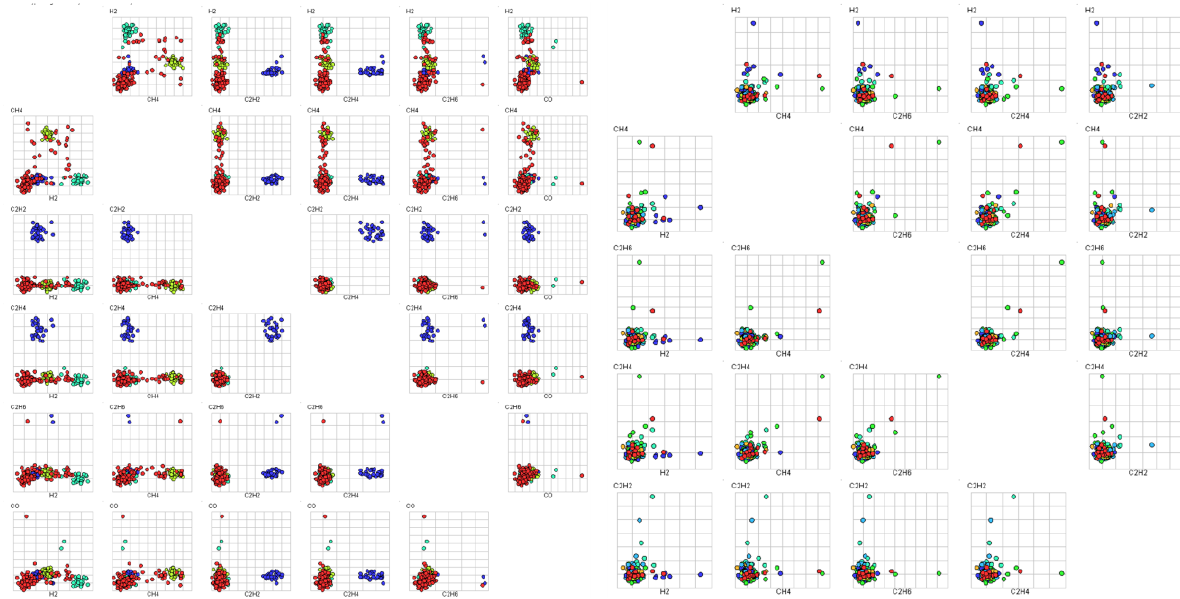
Figure 9. Dissolved gas analysis datasets 5 gas and 6 gas.